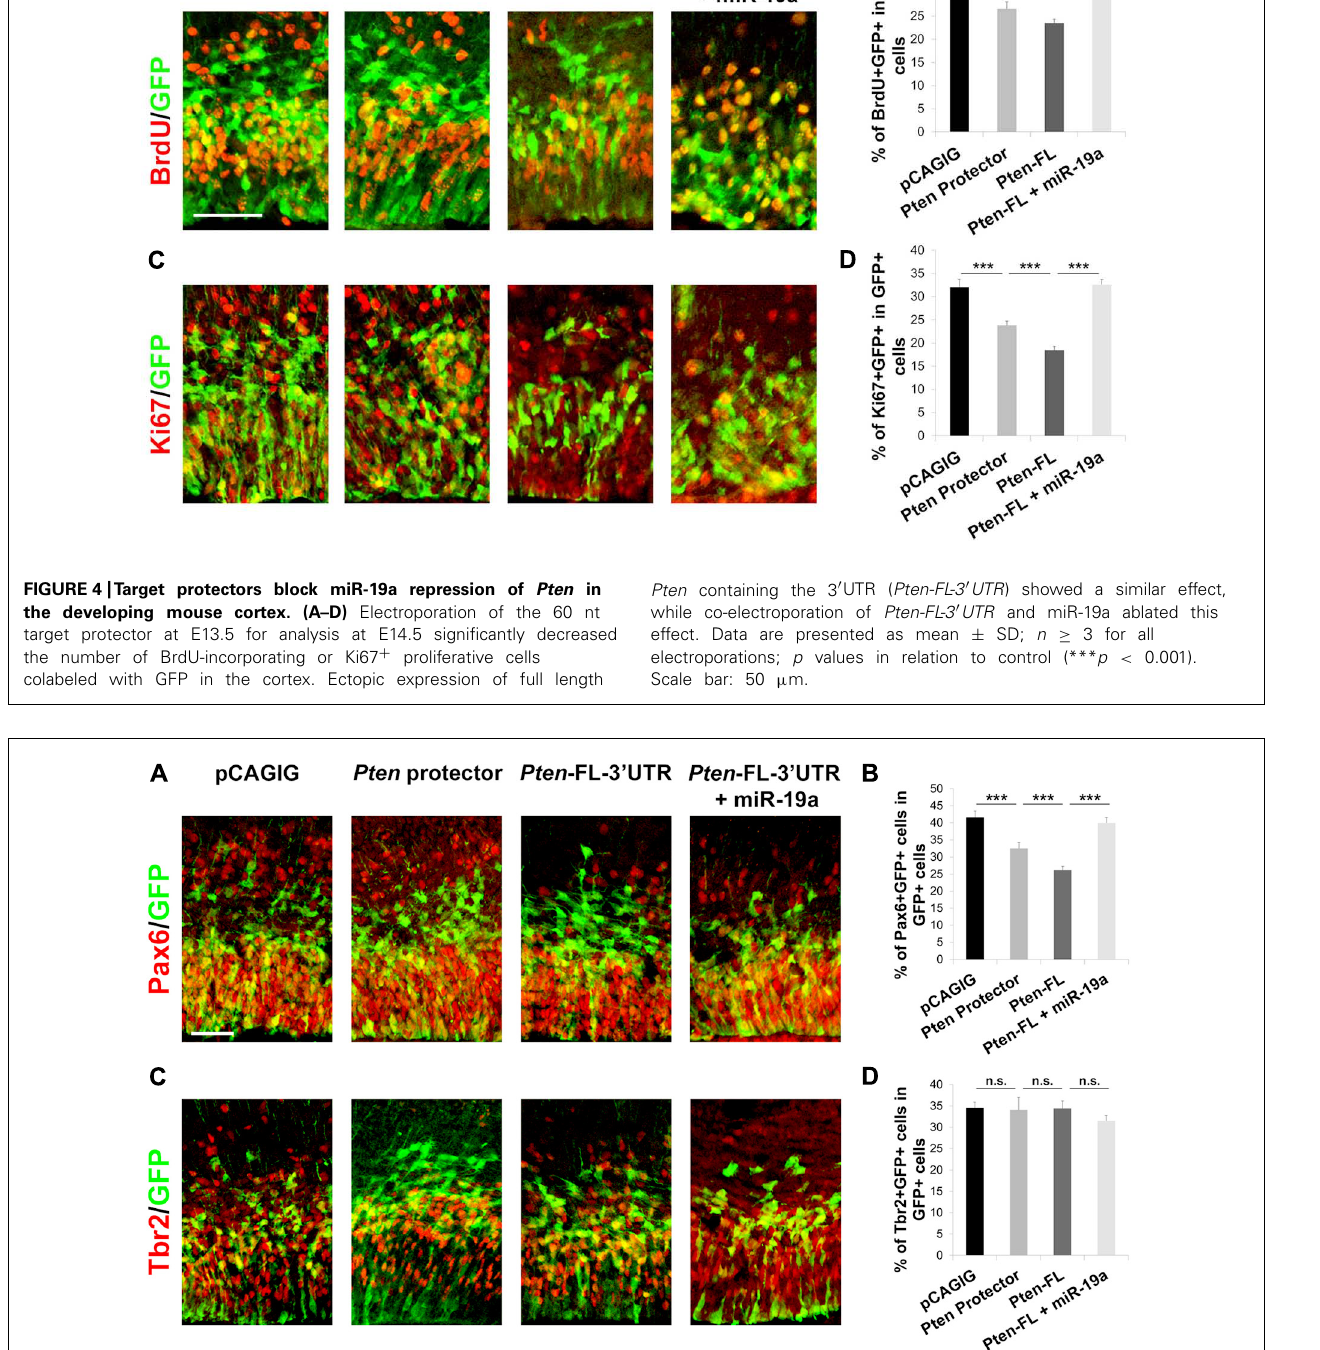
Pten-FL-3 (cid:2) UTR and miR-19a ablated this effect. (C,D) Ectopic expression of the 60 nt target protector, Pten-FL-3 (cid:2) UTR , or Pten-FL-3 (cid:2) UTR and miR-19a had no effect on the number of IPs colabeled with GFP and Tbr2. Data are presented as mean ± SEM; n ≥ 3 for all electroporations; p values in relation to control (*** p < 0.001). n.s., not significant. Scale bar: 50 μ